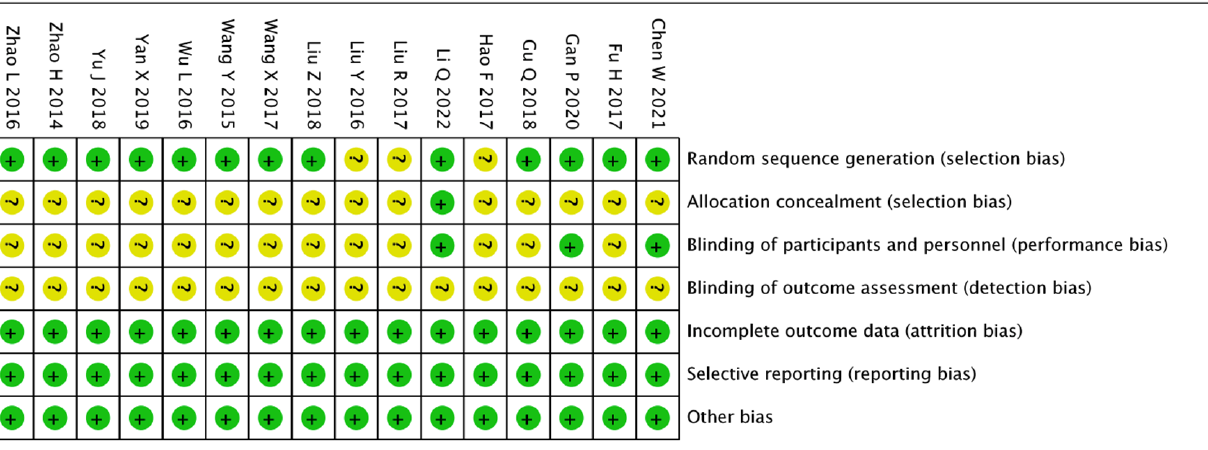
Figure 4. Forest diagram with efficiency comparisons.